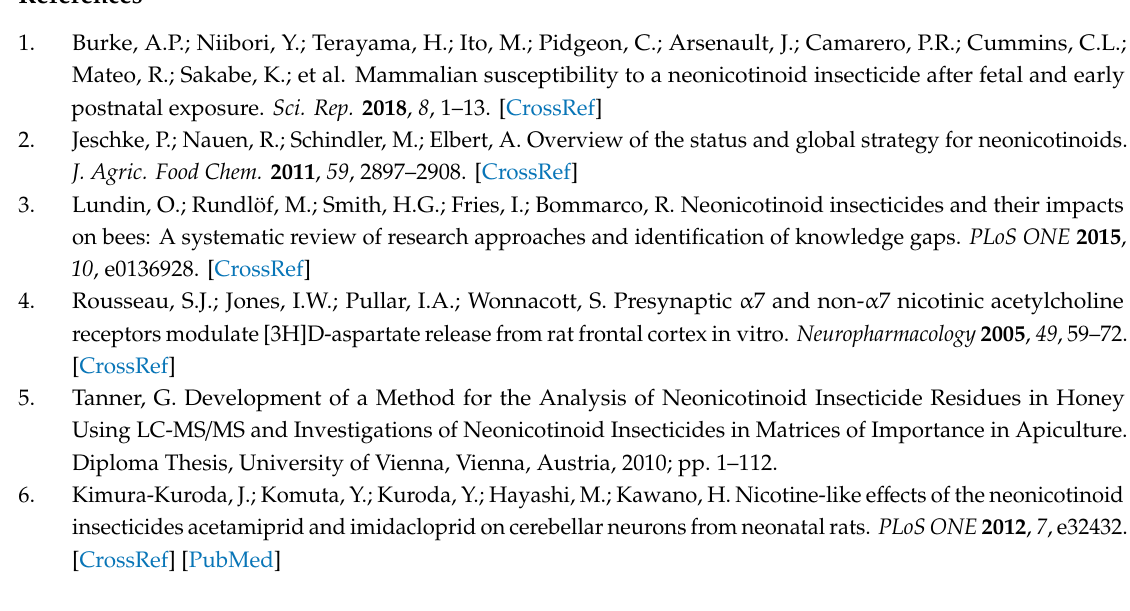
Supplementary Materials: The following are available online, Table S1: Recoveries and repeatability of solid-phase extraction for samples with 20, 10, 5, and 1% EtOH. Table S2: Recoveries and repeatability of solid-phase extraction of 50 and 100 mL of the sample with 10% EtOH. Table S3: Recoveries and repeatability of QuEChERS extraction from acetonitrile and ethanol. Table S4: Recoveries and repeatability of QuEChERS extraction with the addition of graphitised carbon black and C18 in dSPE step. Table S5: Recovery of analytes after filtering through 0.45 µ m membrane filter (CHROMAFIL Xtra PTFE-45 / 25). Table S6: Recoveries and repeatability of combined QuEChERS (first step) and solid-phase extraction (second step) methods. Table S7: Name, chemical structure and molecular weight of the analytes. Table S8: List of matrix-matched (used for MMC) and multicomponent standard working solutions (used for SC). Figure S1a: SRM chromatogram of matrix-matched calibration solution (50 µ g / L of each analyte). All m / z are displayed (except for clothianidin). Figure S1b: SRM chromatogram of matrix-matched calibration solution (50 µ g / L of each analyte): clothianidin m / z are